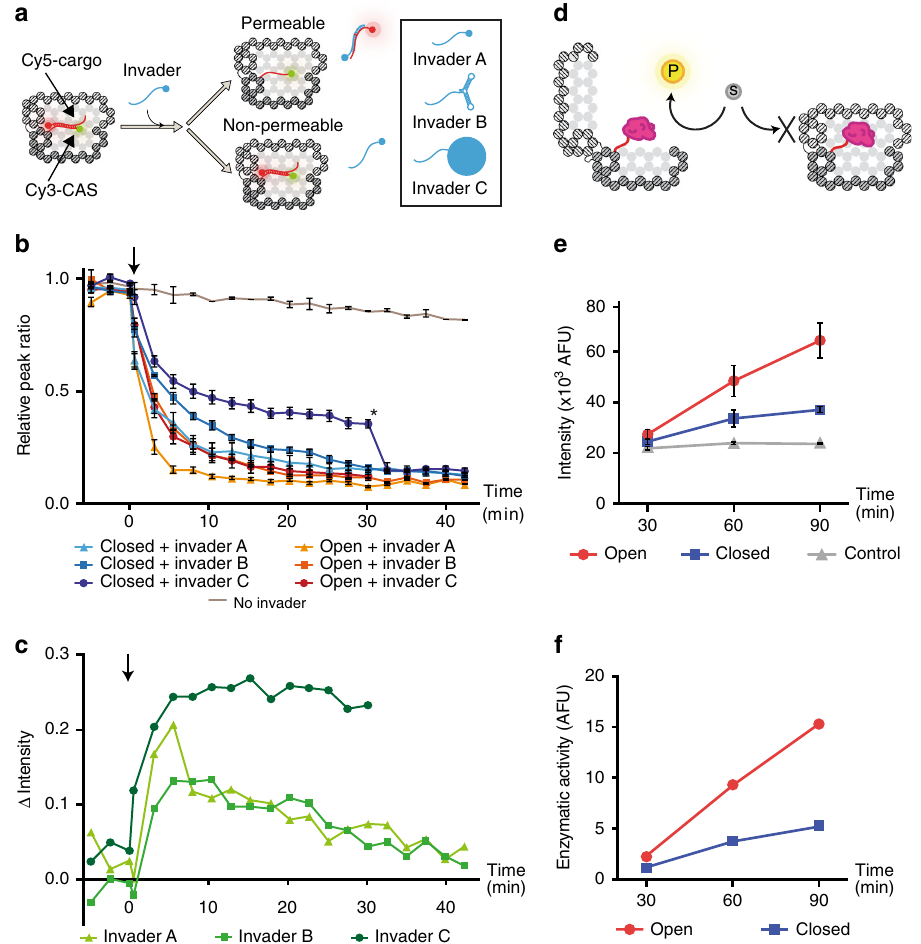
Fig. 3 Permeability assay of the DNA Vault and enzyme activity control. a The DV encloses a fl uorescent cargo consisting of a Cy5-modifed DNA strand annealed onto the Cy3-modi fi ed CAS strand, and exposing a single-stranded toehold region. When an invader is added, it can either penetrate into the nanostructure displacing the cargo, or it is shielded from the cavity, in which case the cargo is unaffected and remains within the DV. Three invader strands of different size are used: simple DNA strand (Invader A), dumbbell DNA strand (Invader B), and Streptavidin-bound DNA strand (Invader C). b Fluorescence data showing the decrease of relative peak ratio upon invader strand addition. Invader strands were added at 0 min and the fl uorescence immediately measured afterwards. The black arrow indicates addition of invaders; the asterisk indicates addition of Invader A to Closed + Invader C after 30 min to con fi rm active shielding of the enclosed cargo from free-diffusing Invader C molecules. Bars indicate one standard error from the mean fl uorescence signal as recorded in either three (Invader B) or four (Invader A and C) replicates. c Quanti fi cation of the shielding effect of the DV calculated as the difference of intensity values between closed and open samples, as shown in panel b . The black arrow indicates addition of invaders. d The proteolytic enzyme aCt (pink) is encapsulated inside the DV, while the substrate (grey circle) is free in solution. The enzyme catalyses the conversion of substrate to product (yellow circle) in the open structure, while the reaction is inhibited in the closed DV. e aCt enzymatic activity measured on open aCt-loaded (blue), closed aCt-loaded (red) and open empty DV (control, grey). Bars indicate one standard error from the mean fl uorescence signal as recorded in three replicates. f , Normalisation of measured enzymatic activity as in e after control subtraction (closed — control at 30 min =